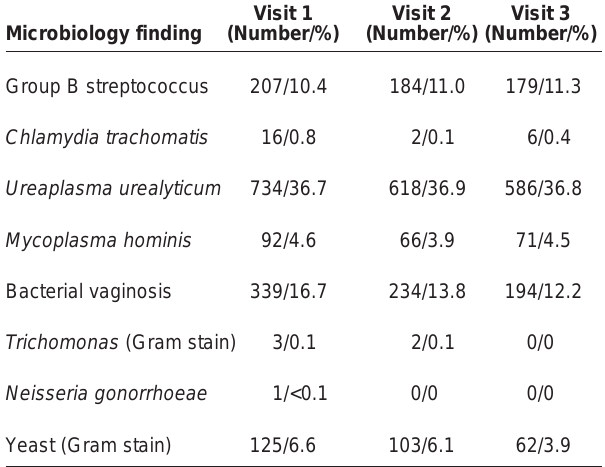
TABLE 9 Pregnancy outcomes of participants in the